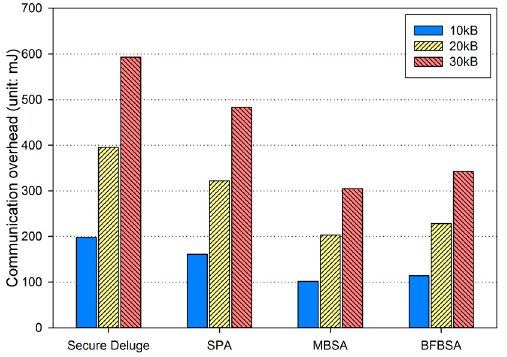
Figure 13. Communication overhead in excellent link quality.